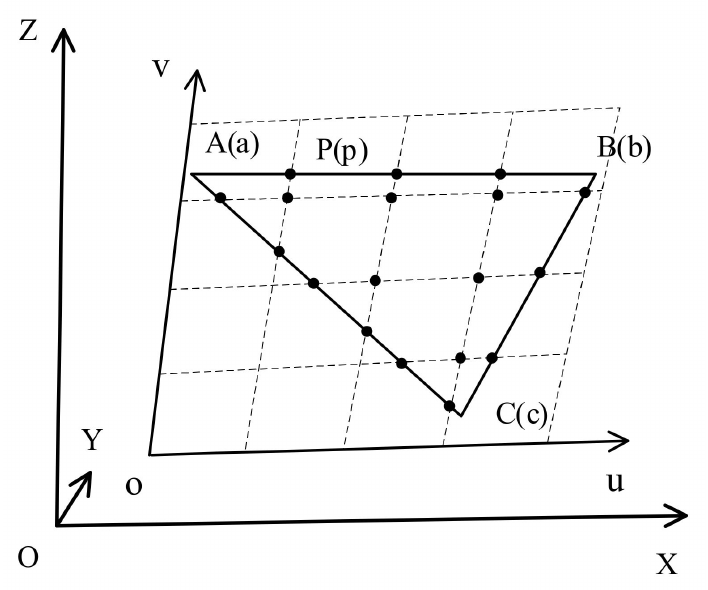
Figure 6. Rectangle clipping.